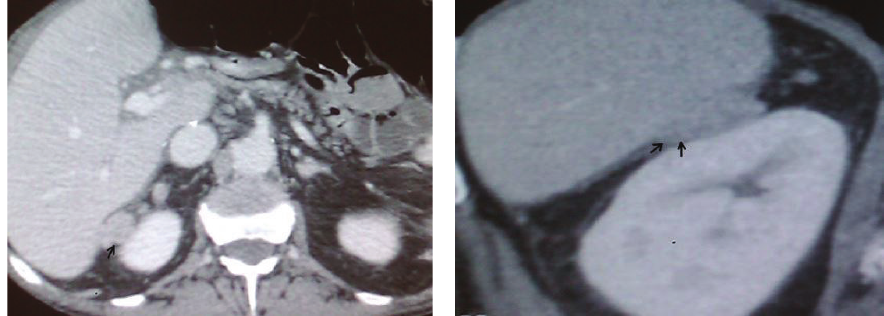
Figure 1: CT with intravenous contrast. Extrahepatic lesion between liver segment 6 and right kidney, largest diameter 2cm.